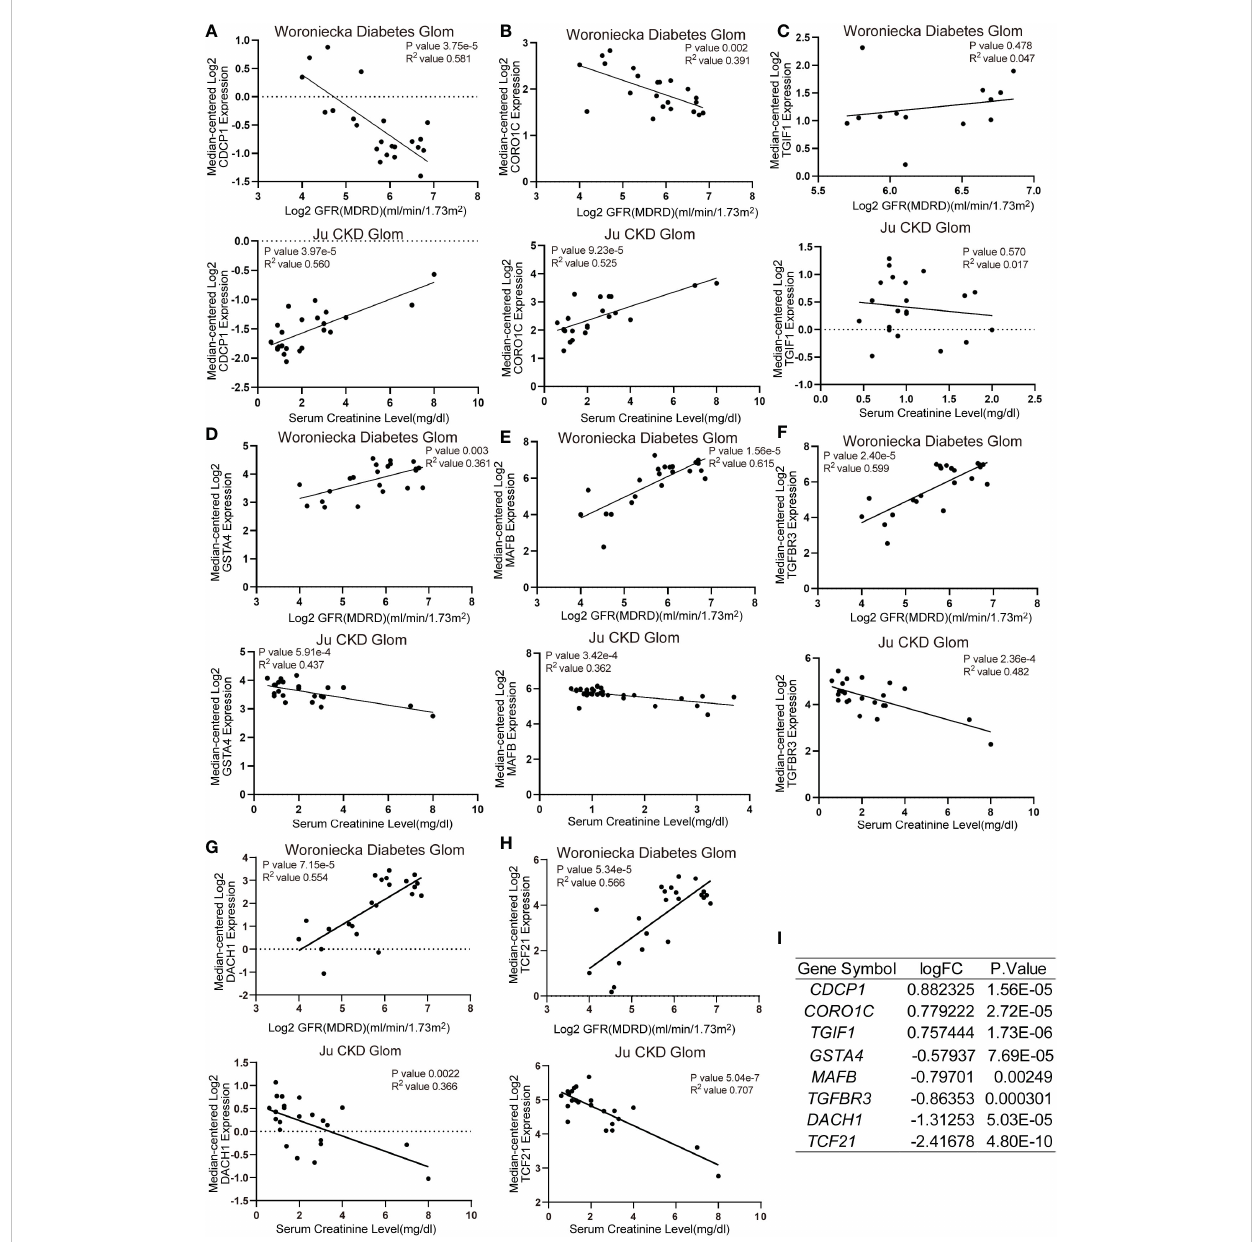
FIGURE 7 Correlation analysis of TISSUE common hub genes and CKD clinical parameters (A – H) The correlation of TISSUE genetic biomarker mRNA levels with estimated glomerular fi ltration rate (eGFR) in the Woroniecka Diabetes Glom Cohort (Top) or serum creatinine (SCr) level in the Ju CKD Glom Cohort (Bottom). (A) CDCP1 ; (B) CORO1C ; (C) TGIF1 ; (D) GSTA4 ; (E) MAFB ; (F) TGFBR3 ; (G) DACH1 ; (H) TCF21 . Data were extracted from www. nephroseq.org. (I) The gene expression level of common hub genes in the discovery